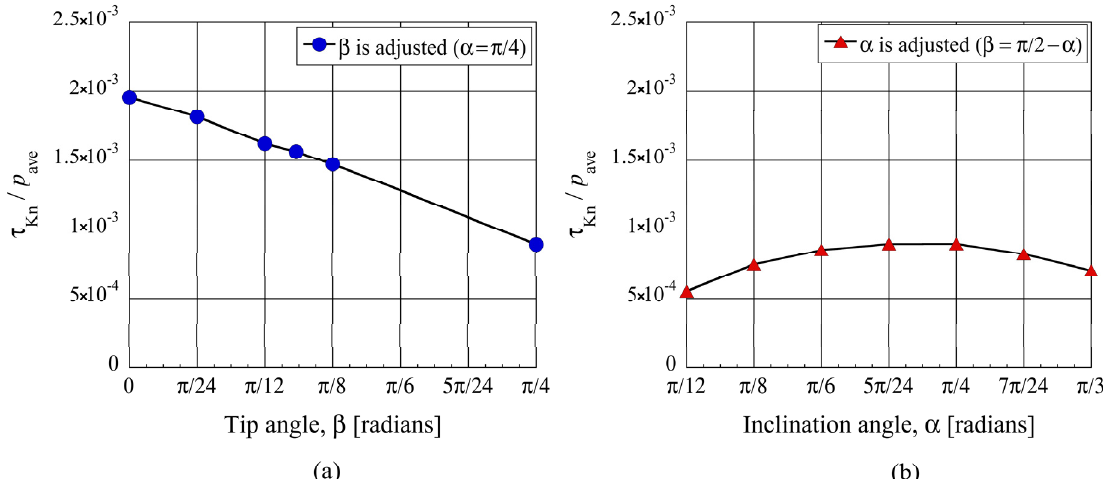
Figure 7. Net tangential Knudsen stresses, i.e., propulsive forces per unit area, at ( a ) different tip angles 𝛽 for the modified ratchet and ( b ) different inclination angles 𝛼 for the ratchet, for Kn = 1 .